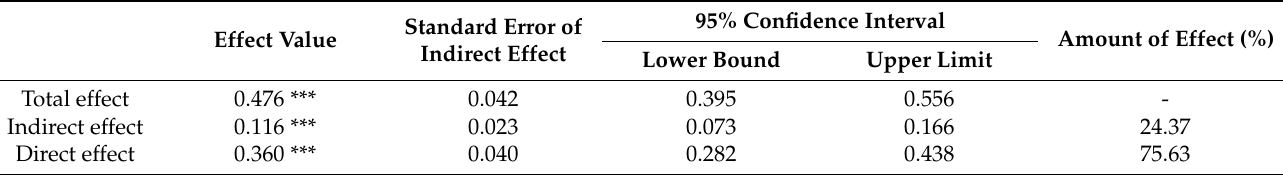
Table 3. Significance test of mediating effect and mediating effect